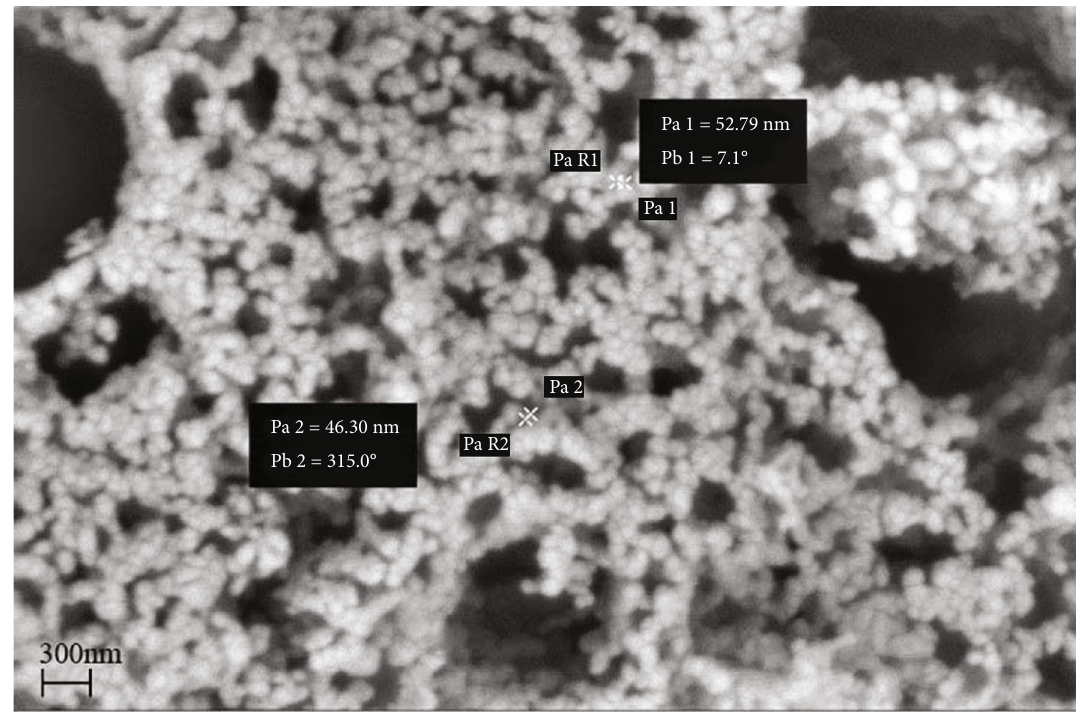
Figure 11: SEM images of CuO nanoparticles derived from Cu(H